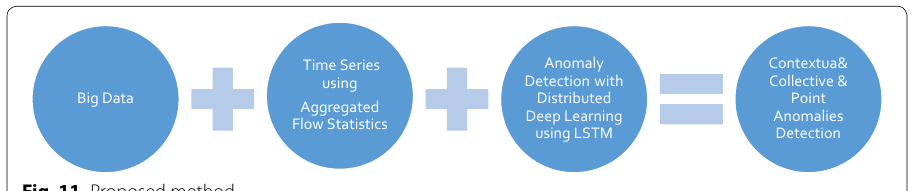
Fig. 11 Proposed